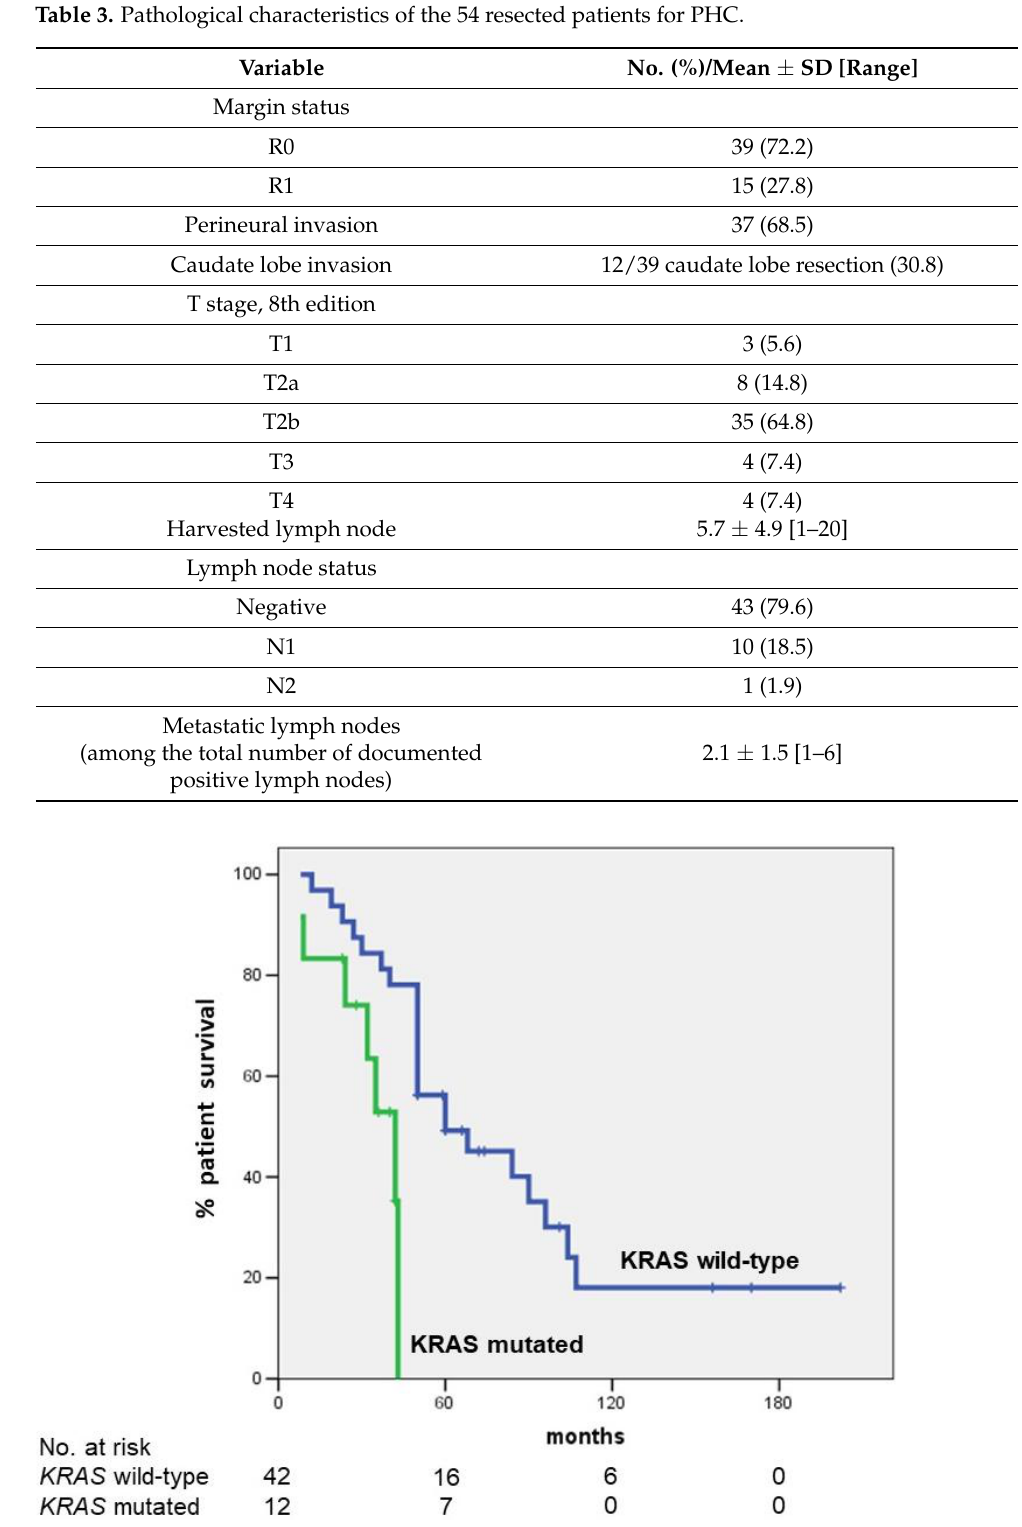
Table 3. Pathological characteristics of the 54 resected patients for PHC.